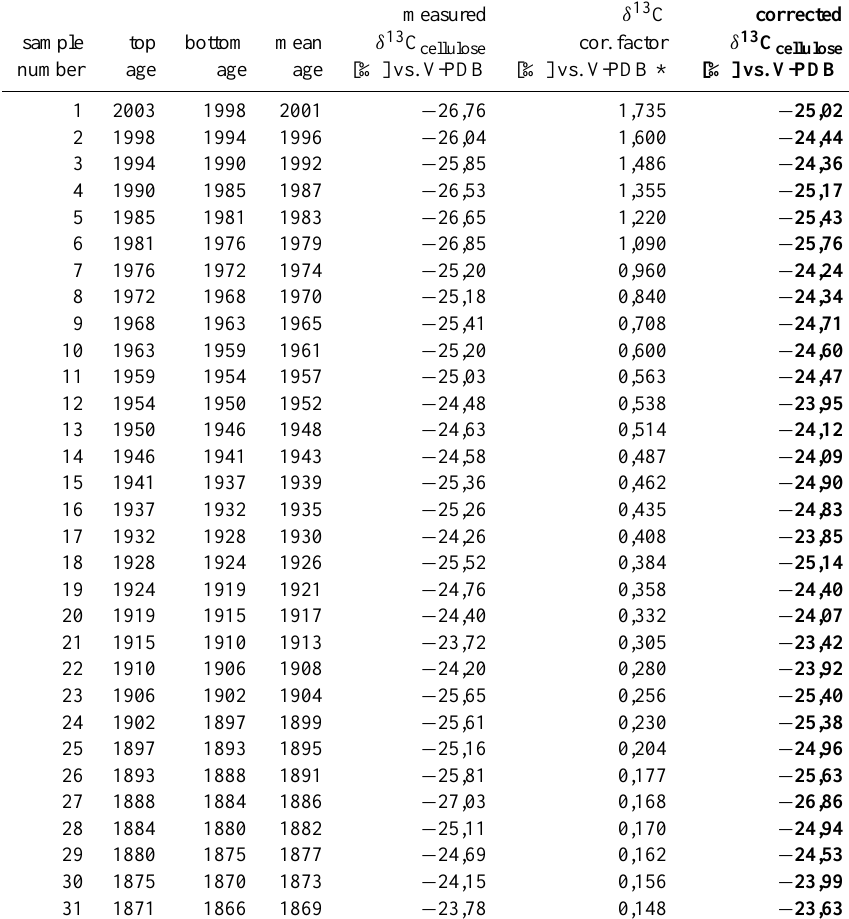
Table 2. Measured δ 13 C values of Sphagnum cellulose chemically extracted from the samples which are younger than 1850 AD, correspond- ing δ 13 C correction factors calculated from annual correction factors shown in Leuenberger (2007), and the resulting Sphagnum δ 13 C cellulose values corrected for the Suess effect, i.e., the antropogenically induced increase in atmospheric 13 CO 2 (values in bold). On the basis of our age-depth model a top age and a bottom age for each sample was calculated narrowing the time span any 2 cm peat increment accumulated to a specific number of years (full years). Each δ 13 C correction factor was calculated as a mean of six to seven annual correction factors (Leuenberger, 2007) corresponding to the time span each individual peat increment has been